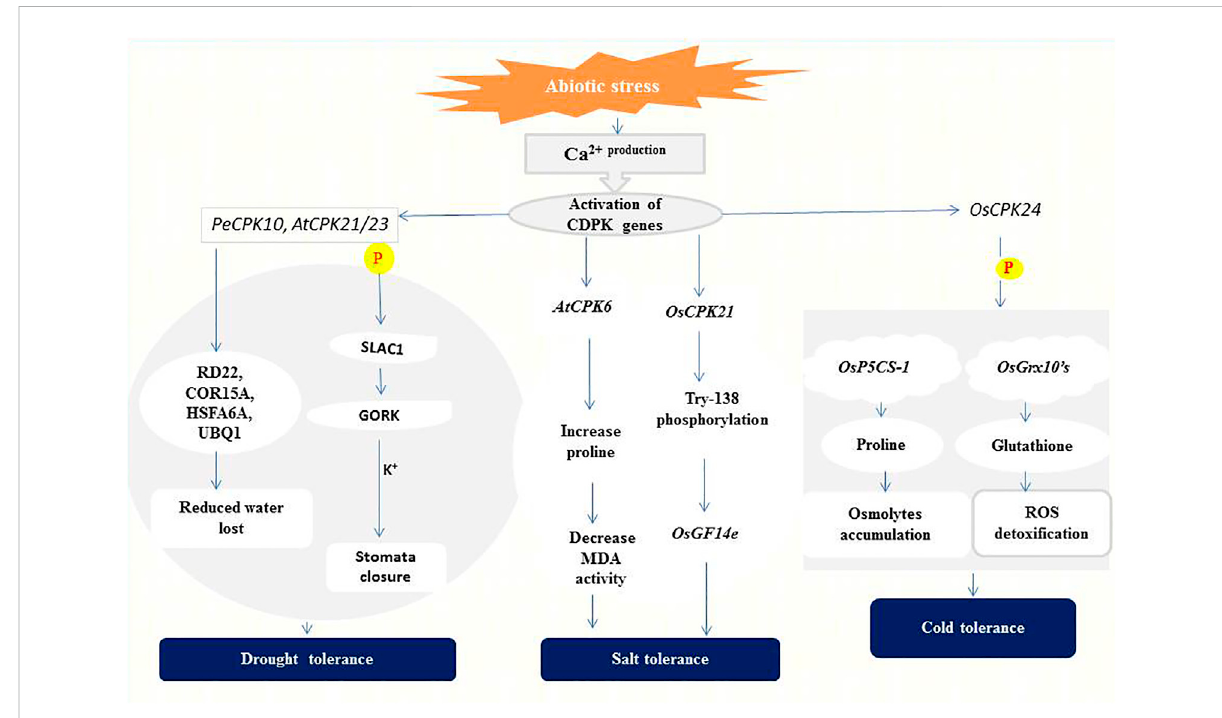
FIGURE 2 A representation of CDPK functions in abiotic stress signaling. CPK21/23 phosphorylates ( P ) SLAC1 to activate K + ions ef fl ux generation leading tostomatalclosure(Geigeretal.,2010). PeCPK10 ontheotherhandinducesdroughttolerancethroughtheexpressionofdrought-responsivegenes as stated above (Chen etal., 2013). Overexpression of AtCPK6 elevatesproline level therebyrepressing Malondialdehyde (MDA)generation (Xu et al., 2010). Whiles OsCPK21 interacts with OsGF14e by partially phosphorylating Try-138 to initiate the salt tolerance response (Chen et al.,